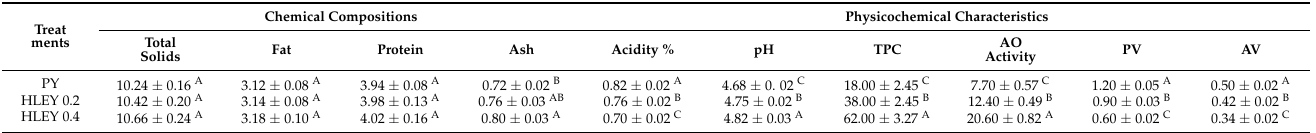
Table 1. Chemical compositions and physicochemical characteristics of yogurt fortified with aqueous Hawthorn leaf extract.